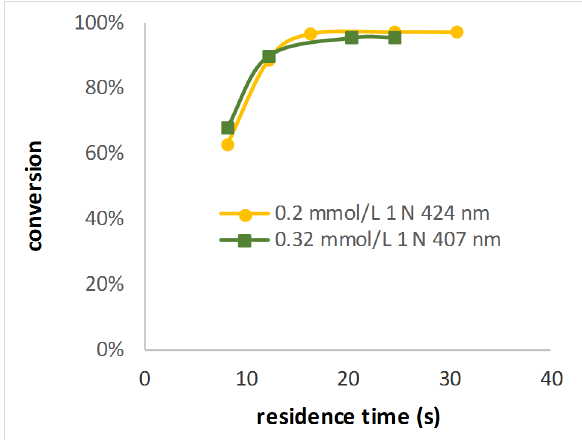
Figure 6: Transmission spectra of TPP ( H ) and emission spectra of LEDs with maxima at 407 and 424 nm, respectively (both scaled to 100%).